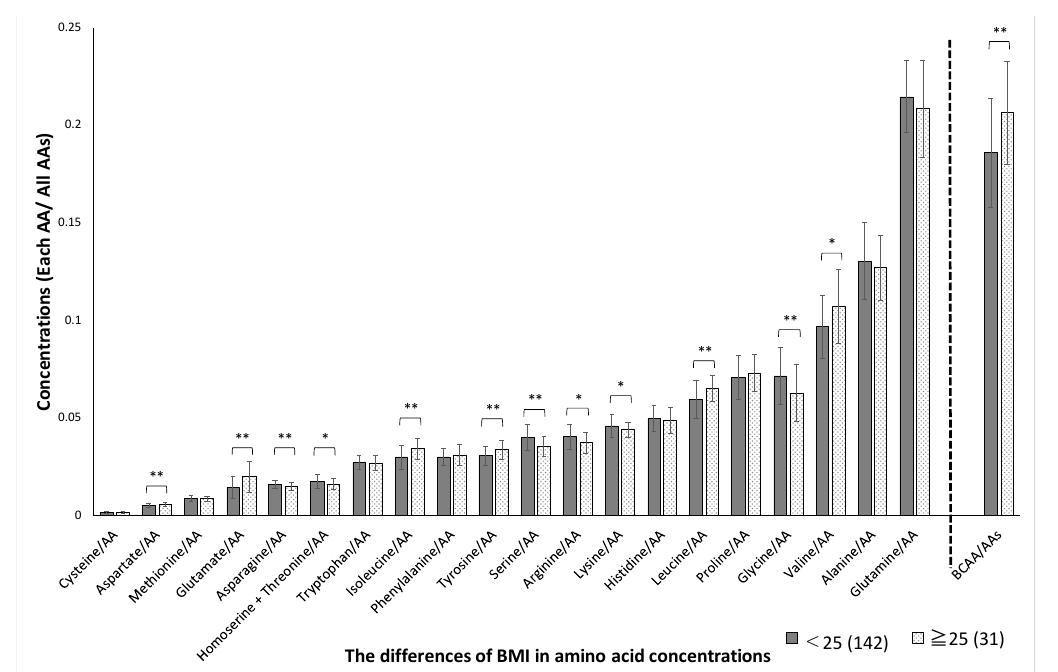
Figure 3. BMI-related differences in amino acid concentrations. The absolute concentration was divided by the total AA concentration, yielding the relative concentration. Participants were divided into two groups based on BMI 25. AAs, amino acids; BCAAs, branched-chain amino acids BCAAs, branched-chain amino acids. * p < 0.05, ** p < 0.01 in BMI < 25 versus BMI ≥ 25.